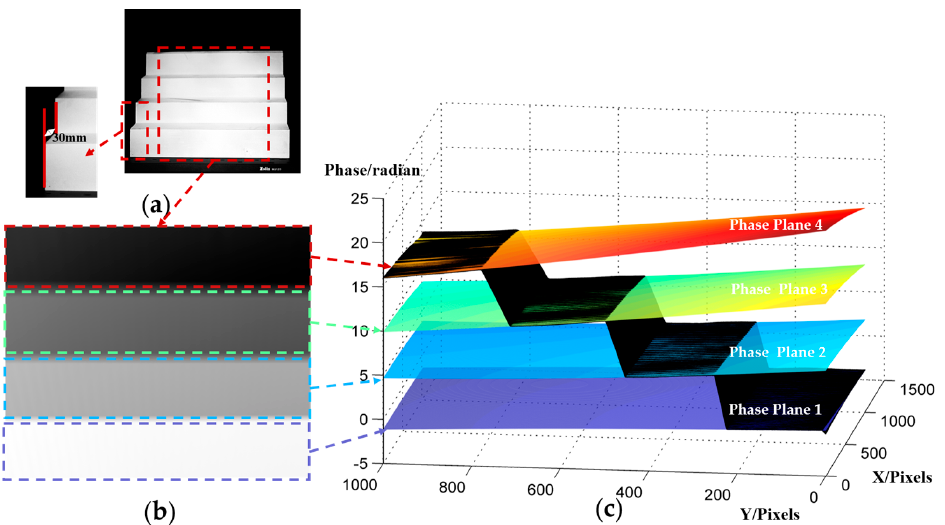
Figure 5. System calibration process: ( a ) Photograph of the standard block; ( b ) Absolute phase of the standard block; ( c ) Four fitted absolute phase planes based on the standard block’s absolute phase.